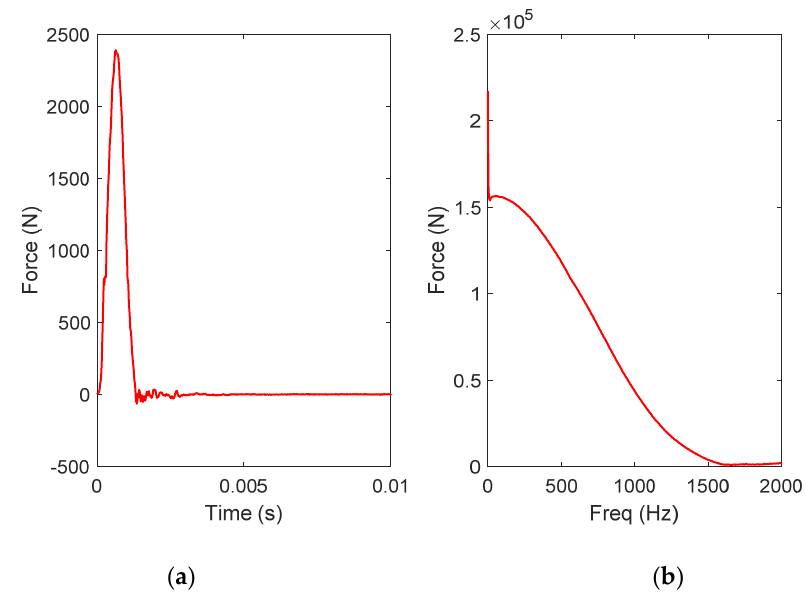
Figure 9. Hammer impact in ( a ) time domain ( b ) frequency spectrum. Raw acceleration data (time domain) of layer 1 and layer 2 of Pole 1 at 0°, 90°, and 180° position and their corresponding frequency spectrums are shown in Figures 10–12, respectively. Frequency response function (FRF) is implemented here to normalise the effect of hammer impact. From the results, it can be observed that the time acceleration signals from all 12 sensors are non-stationary and exhibit nonlinear characteristics. Since all the time information is lost after performing FRF, it is impossible to predict how the frequency components present in the raw acceleration signals and how it changes over time. It is also very difficult to identify which peaks in the frequency spectrum are the dominant frequency.